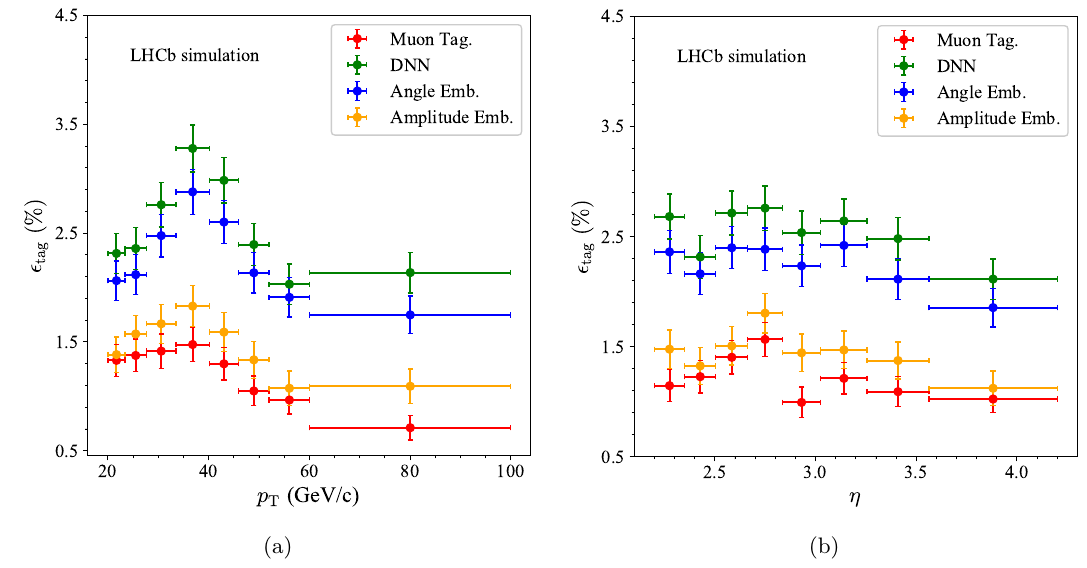
Figure 7. Tagging power (cid:15) tag with respect to (a) jet p T and (b) jet η for the muon dataset . The Angle Embedding circuit and the DNN show similar